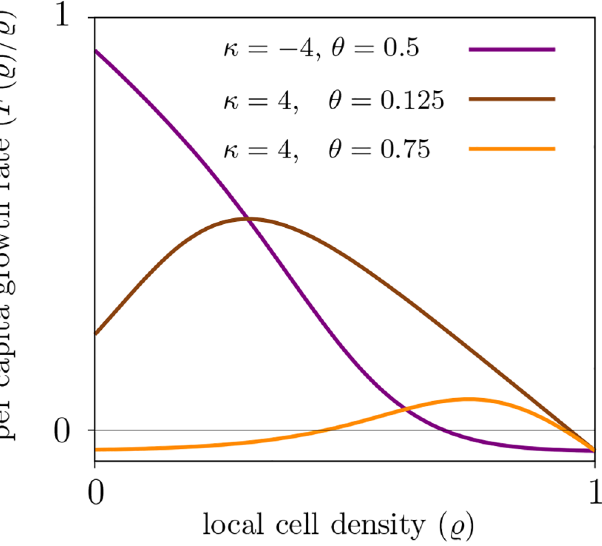
Fig 5. Per capita growth rate of the mean-field description Eq (2) depends on the type of phenotypic plasticity. In the repulsion case ( κ < 0), the per-capita growth rate for small densities is always positive (purple line). In the attraction case ( κ > 0), the per-capita growth rate is reduced at low density (brown line) and can even become negative (Allee effect, orange line). Model parameters are r b = 0.2, r d = 0.01, K =